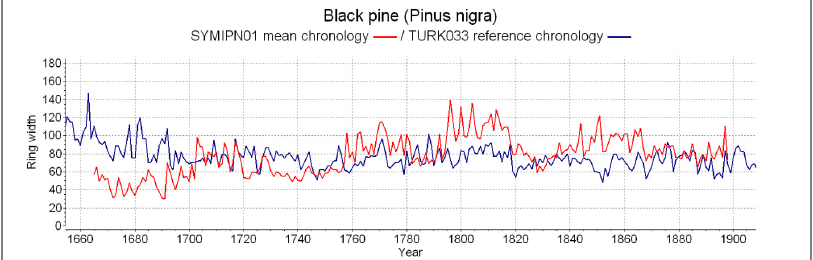
Figure 3. Visual cross-matching of the Black pine chronology (SYMIPN01, in red) with the Pinus nigra chronology from the area around Alanya and Cevizli in Turkey (TURK033, in blue) [36]. Only the overlapping period of the two chronologies is presented here.